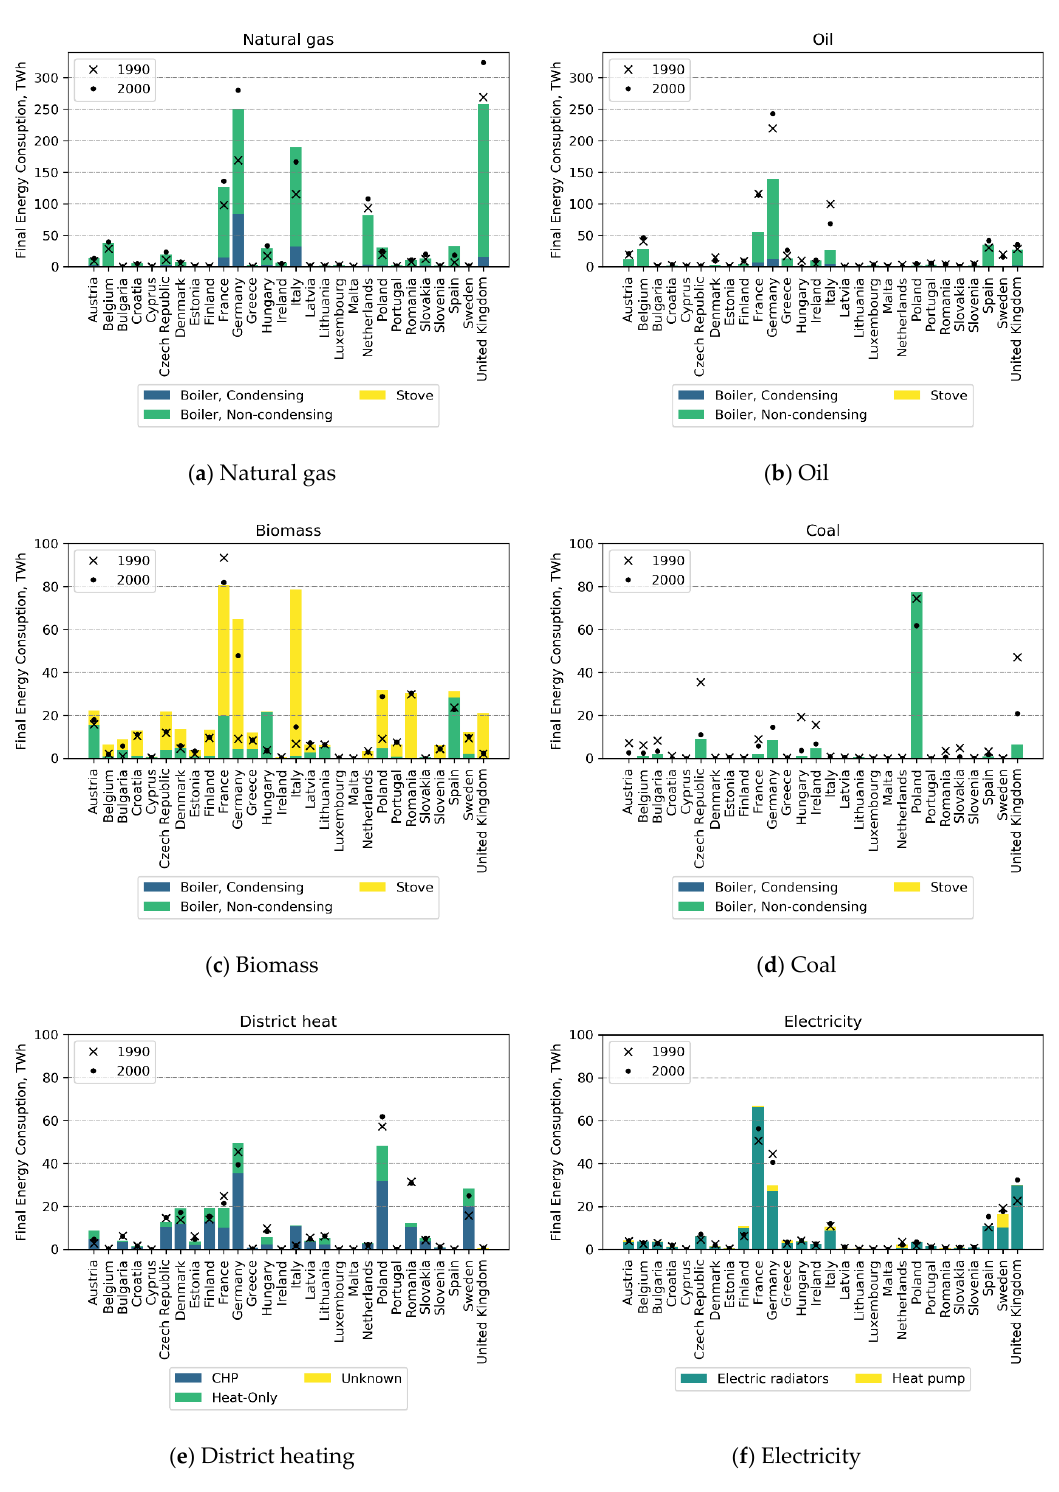
Figure 6. Final residential heat consumption for each EU-28 MS by type of end-use residential heat technology for ( a ) Natural gas, ( b ) Oil, (c) Biomass, ( d ) Coal, ( e ) District heating, and ( f ) Electricity. Note: ( a ) and ( b ) have a different x-axis scale than the remaining figures. For biomass, France (93 TWh), Italy (79 TWh) and Germany (65 TWh) had the highest FEC among the EU-28 in 2015. The analysis show that Italy experienced a significant high growth in biomass consumption from 7 TWh in 1990, increasing more than 10-fold the FEC of biomass for